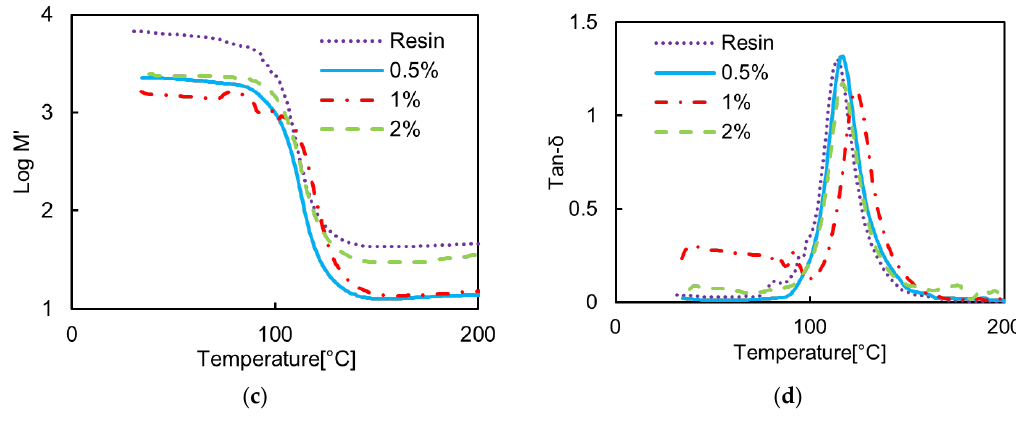
Figure 6. Measured storage modulus M ’ and loss tangent tanδ vs. temperature of the neat vinyl-ester resin and of the vinyl-ester-based composites filled with GNPs at increasing wt % concentration: ( a ) M ’ and ( b ) tanδ at 5 Hz; ( c ) M ’ and ( d ) tanδ at 30 Hz.